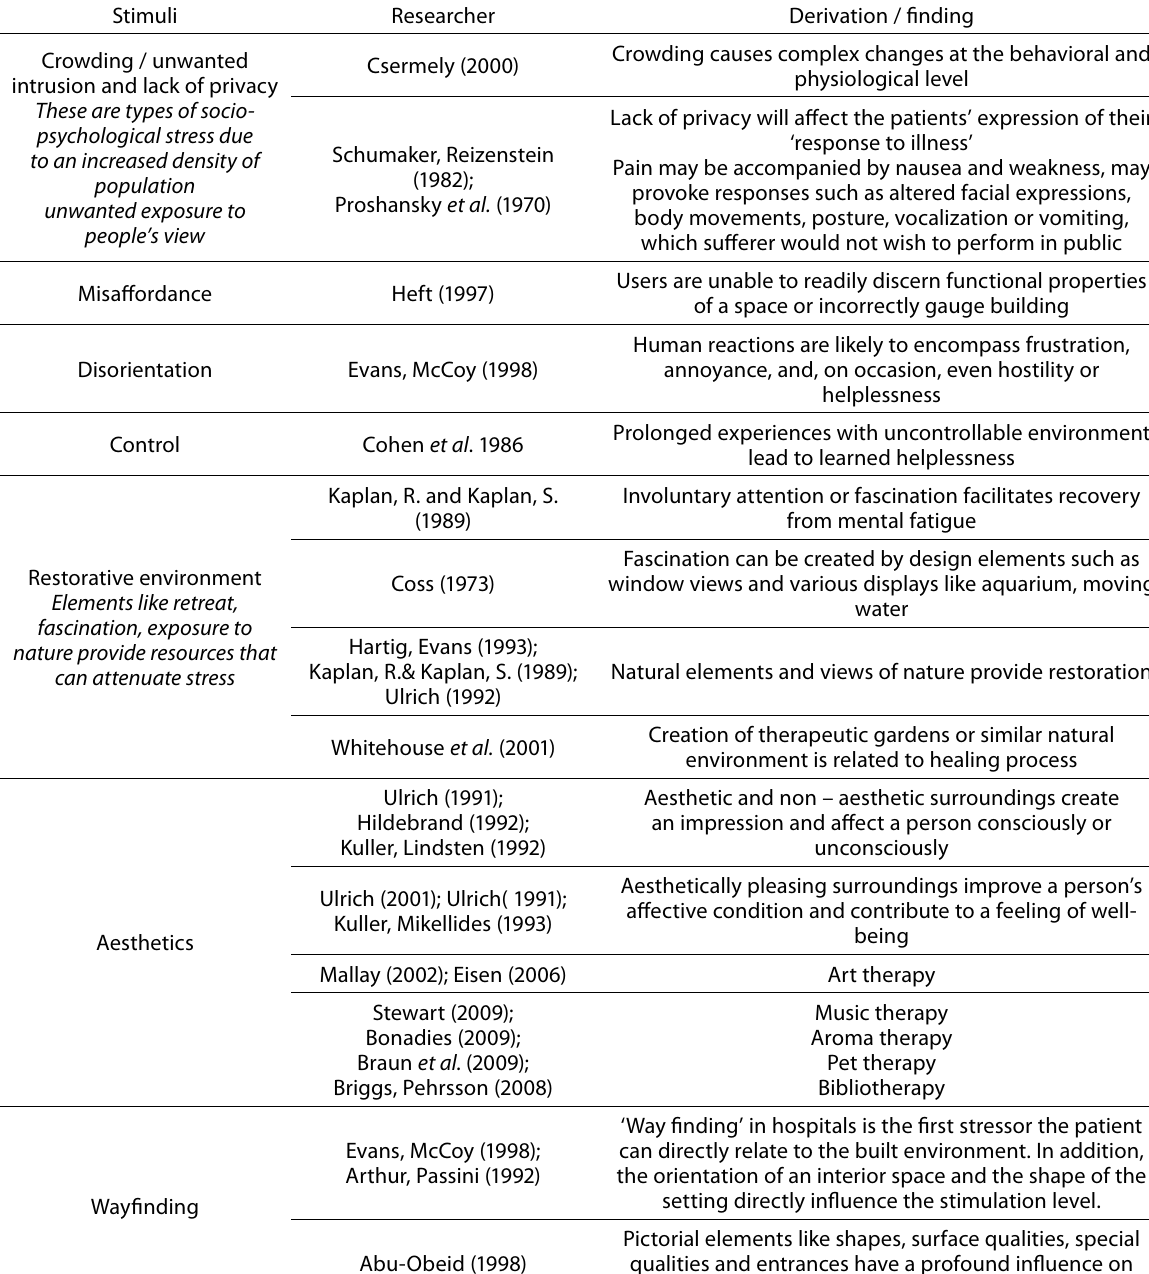
Table 1. a summary of findings from earlier research in this field Stimuli